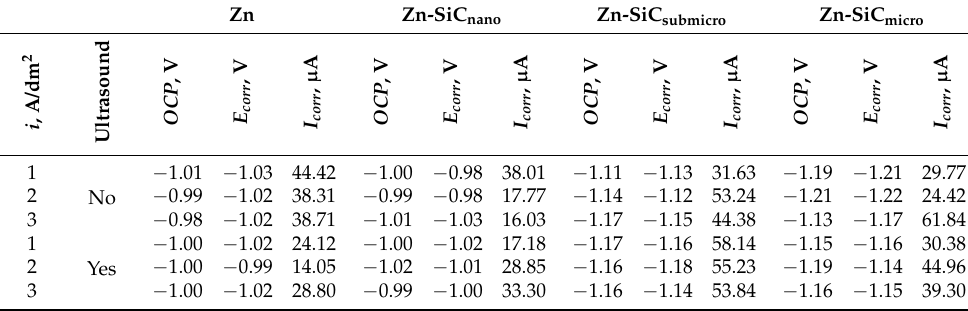
Figure 6. Chronopotentiometric and Tafel curves recorded for Zn and Zn-SiC coatings deposited at different conditions: ( a ) Zn, ( b ) Zn-SiC nano , ( c ) Zn-SiC submicro , and ( d ) Zn-SiC micro (black—1 A/dm 2 , red—2 A/dm 2 , blue—3 A/dm 2 ; solid lines—no ultrasound, dashed lines—ultrasound). Table 2. Values of OCP, E corr , and I corr determined for particular coatings based on data presented in Figure